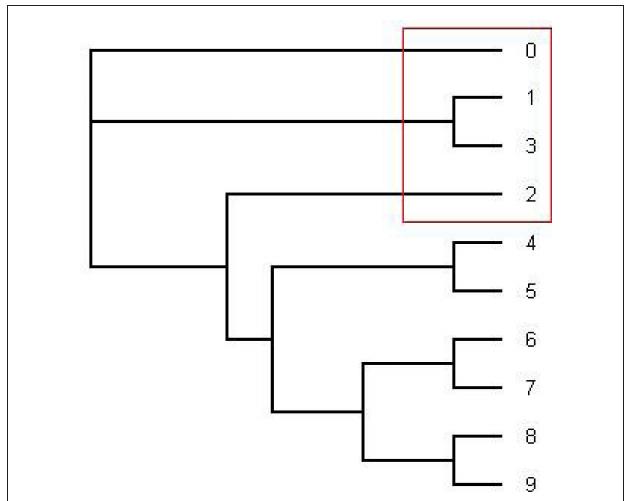
Figure 3 | The tree written in the dark blue (series 1) in Figure 2. This is an unrooted tree. This is the most likely tree topology from position 140 to 300. The software from Webb et al. (2009) and RDP3 Martin et al. (2005b) indicate a potential recombination event among taxa 0, 1, 2, and 3 in the red rectangle.